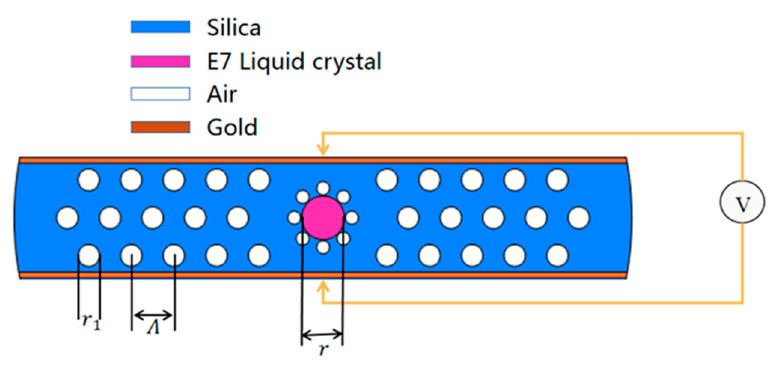
Figure 1. Suggested flat-type PCF.